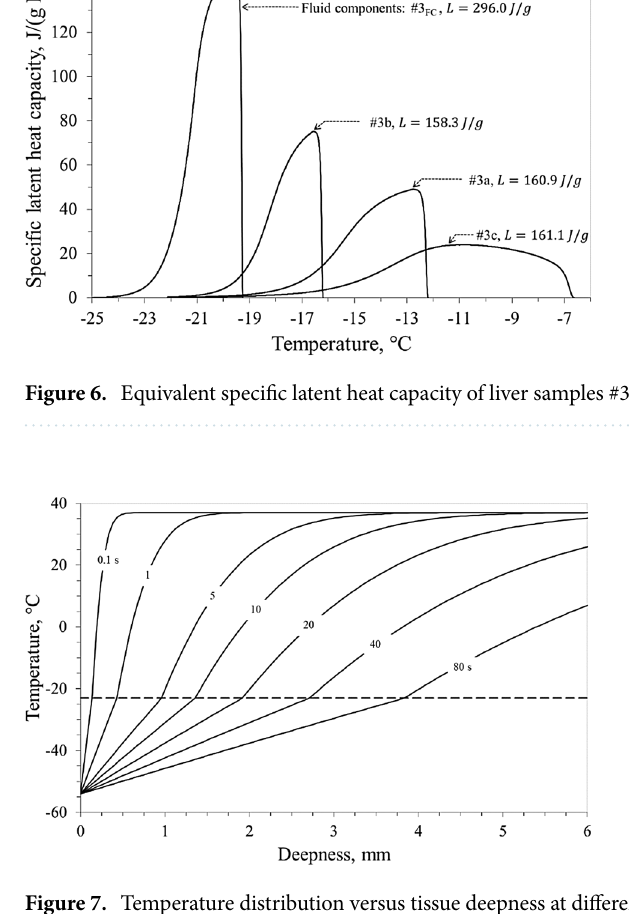
Figure 7. Temperature distribution versus tissue deepness at different time obtained from a constant ablative temperature of − 54 °C; dashed line refers to ice onset temperature of − 23 °C.